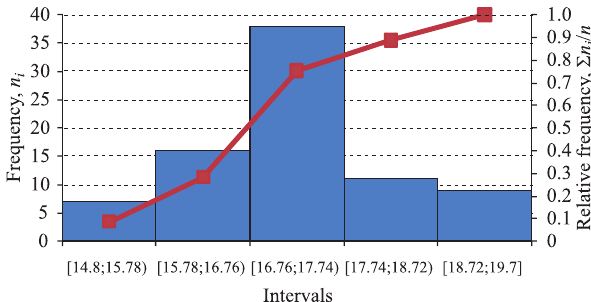
Fig. 5. Histogram of SZ values of resistance to fragmentation of crushed granite and distribution function